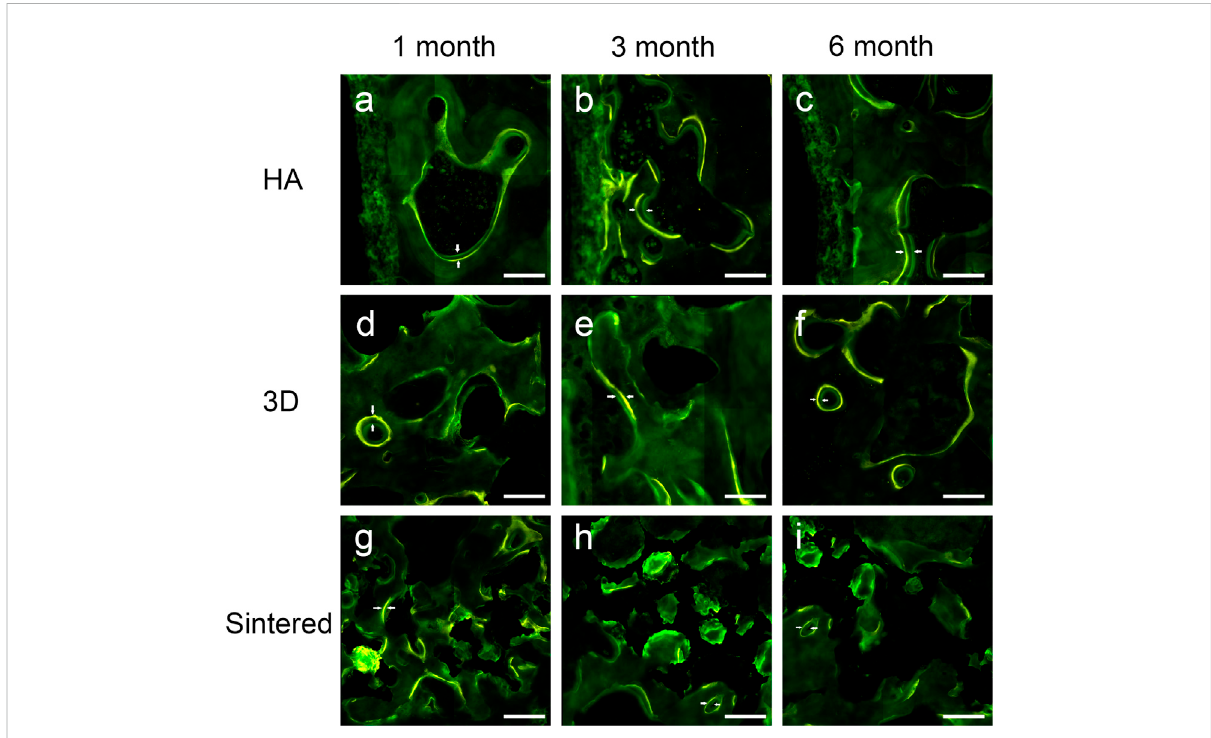
FIGURE 7 Fluorescently labeled photographs of the three materials at 1, 3, and 6 months of follow-up. (A – C) The fl uorescently labeled photos of HAcoated titanium alloy acetabular cup at 1 (A), 3 (B), and 6 (B) months. (D – F) Fluorescently labeled photos of 3D-printed porous titanium alloy acetabularcupat1(d),3(E),and6(F)months.(G – I)Fluorescentlylabeledphotosofsinteredporoustitaniumalloyacetabularcupat1(G),3(H),and6 (I) months. The scale was 200 μ m. Double white arrows in the fi gure denote the fl uorescence marker for new bone growth interval.